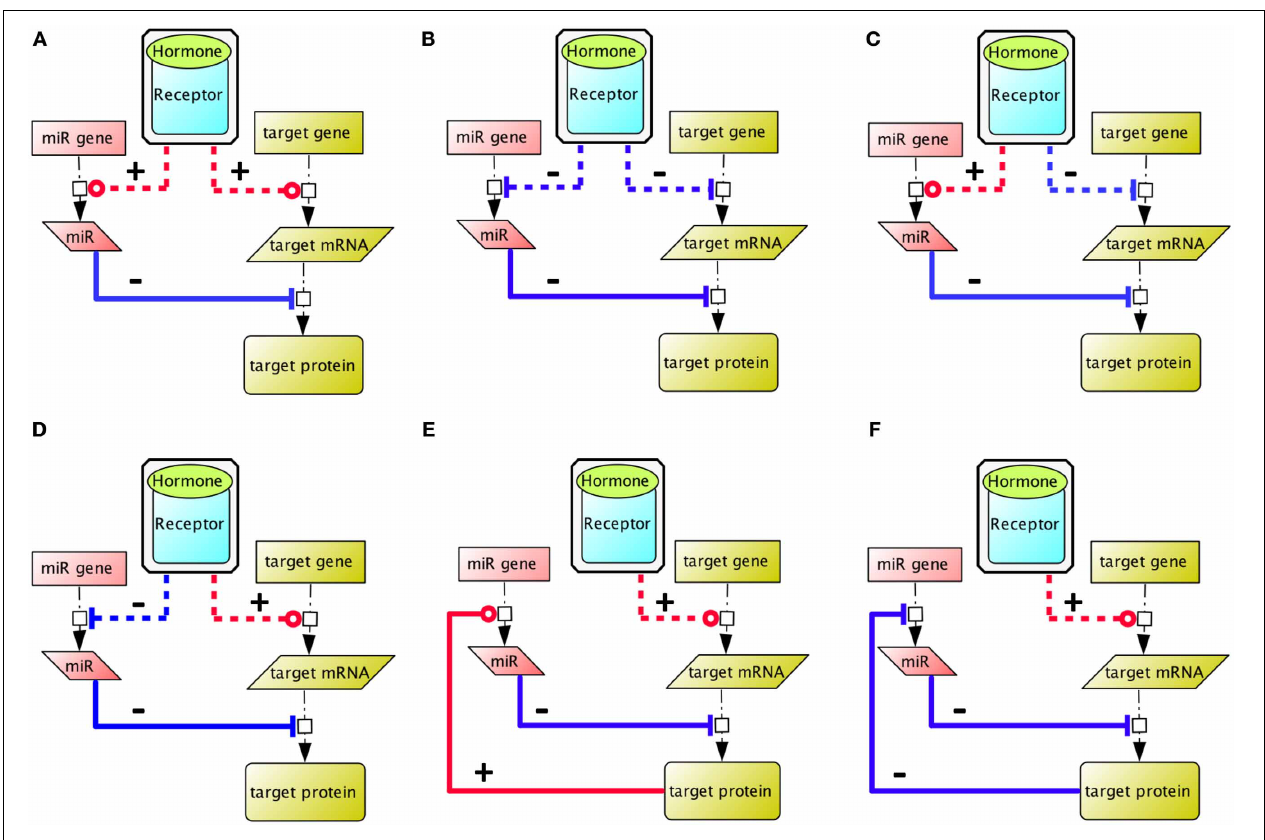
FIGURE 1 | Different ways whereby co-regulation of a microRNA circuit and gene circuit by a hormone input can impact on the global equilibrium within the ultimate expression pattern. (A,B) The hormone regulates positively (red) and negatively (blue) the microRNA and the target gene expression, hence the resulting target protein expression level depends on the expression ratio of microRNA vs. target mRNA. (C) This box illustrates that target gene expression tends to be lower in cells where the targeting